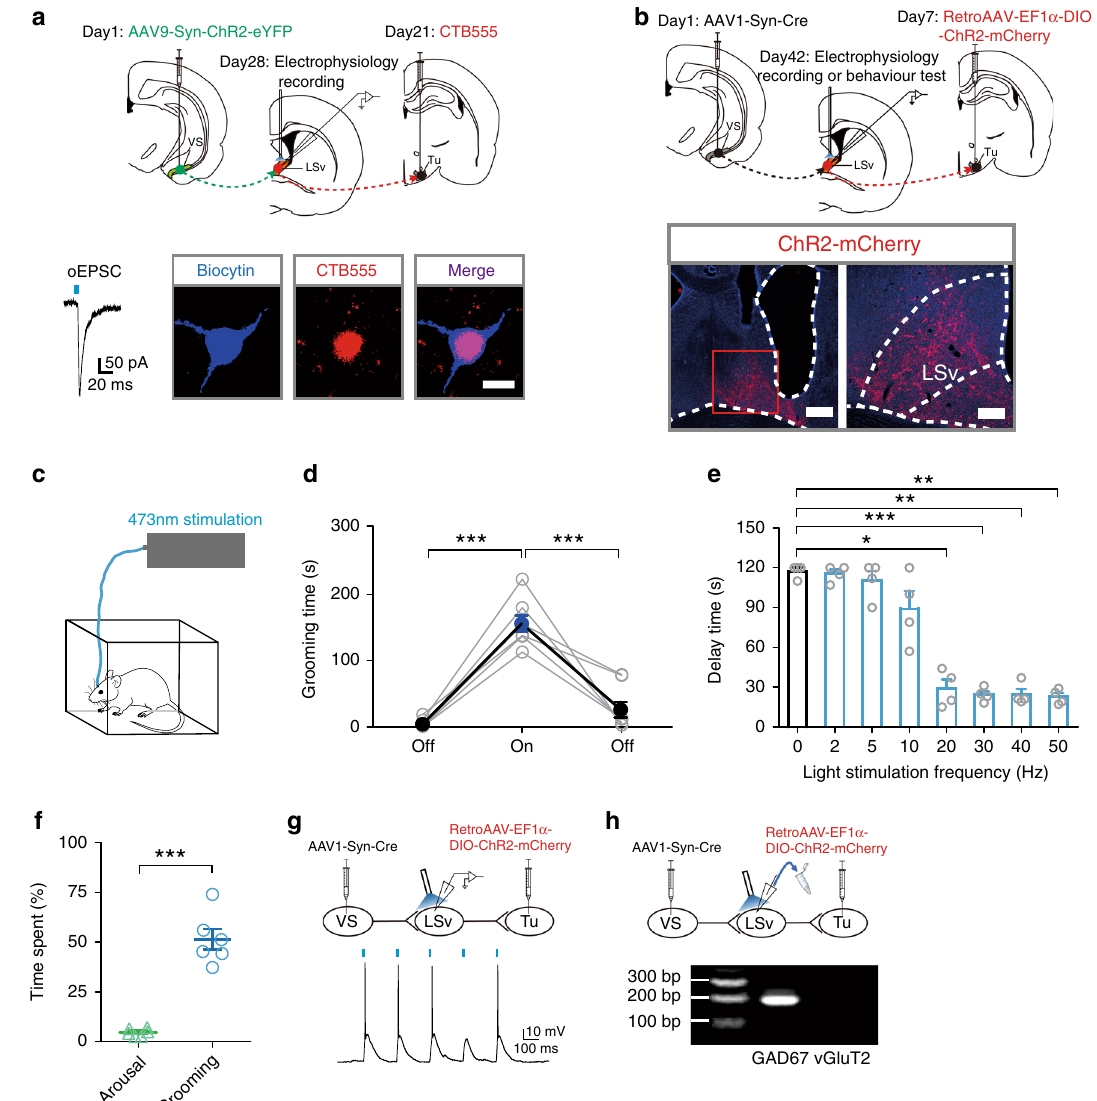
Fig. 4 The VS → LSv → Tu disynaptic limbic circuit modulates grooming behaviour. a Upper panel: injection paradigm to con fi rm that neurons in LSv innervated by VS are neurons that send signals to Tu. AAV9-Syn-ChR2-eYFP was injected into VS and CTB-555 was injected into Tu. Lower panel: An example of a biocytin-tagged LSv neuron that generated EPSCs in response to stimulation of VS → LSv terminals was also labelled by CTB-555. Scale bar, 10 μ m. b Experimental strategy to elucidate the role of VS → LSv → Tu circuitry in grooming. Upper panel: AAV1-Syn-Cre was injected into VS and retroAAV-EF1 α -DIO-ChR2-mCherry was injected into Tu. An optical fi bre was implanted onto LSv. Lower panel: as a result, only neurons in LSv that simultaneously received innervation from VS and projected to Tu could express mCherry as con fi rmed by confocal microscopy. Left, scale bar, 500 μ m; Right, scale bar, 200 μ m. c – e In these rats, in vivo light delivery onto LSv activated the VS → LSv → Tu pathway speci fi cally in vivo c and signi fi cantly increased grooming behaviour ( d , n = 8, F (1.260, 8.822) = 64.89, P < 0.0001, one-way repeated measures ANOVA with Tukey post-hoc test; pre-off vs. on, *** P < 0.0001; on vs. post-off, *** P = 0.0006) in a frequency-dependent manner ( e , n = 4, F (1.517, 4.551) = 63.70, P = 0.0006, one-way repeated measures ANOVA with Tukey post-hoc test; 0 vs. 20 Hz, * P = 0.0134; 0 vs. 30 Hz, *** P < 0.0001; 0 vs. 40 Hz, ** P = 0.0013; 0 vs. 50 Hz, ** P = 0.0020). f Time spent in arousal and grooming behaviours in the initial 2 min of stimulation of the VS → LSv → Tu circuitry. n = 6; Time spent, *** P < 0.0001; Student ’ s paired two-tailed t -test. g Validation of functional ChR2 was con fi rmed by in vitro optogenetic stimulation in whole-cell recording following in vivo experiments. h Single-cell RT-qPCR result of cytoplasmic content of patched LSv neurons was positive to GAD67 but negative to vGluT2. All data are presented as mean ± SEM. Source data are provided as a Source Data fi